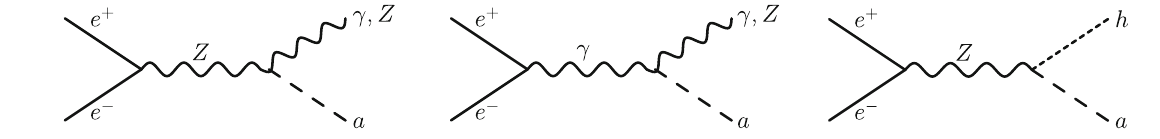
Fig. 1 Tree-level Feynman diagrams for the processes e + e − → Xa with X = γ, Z ,